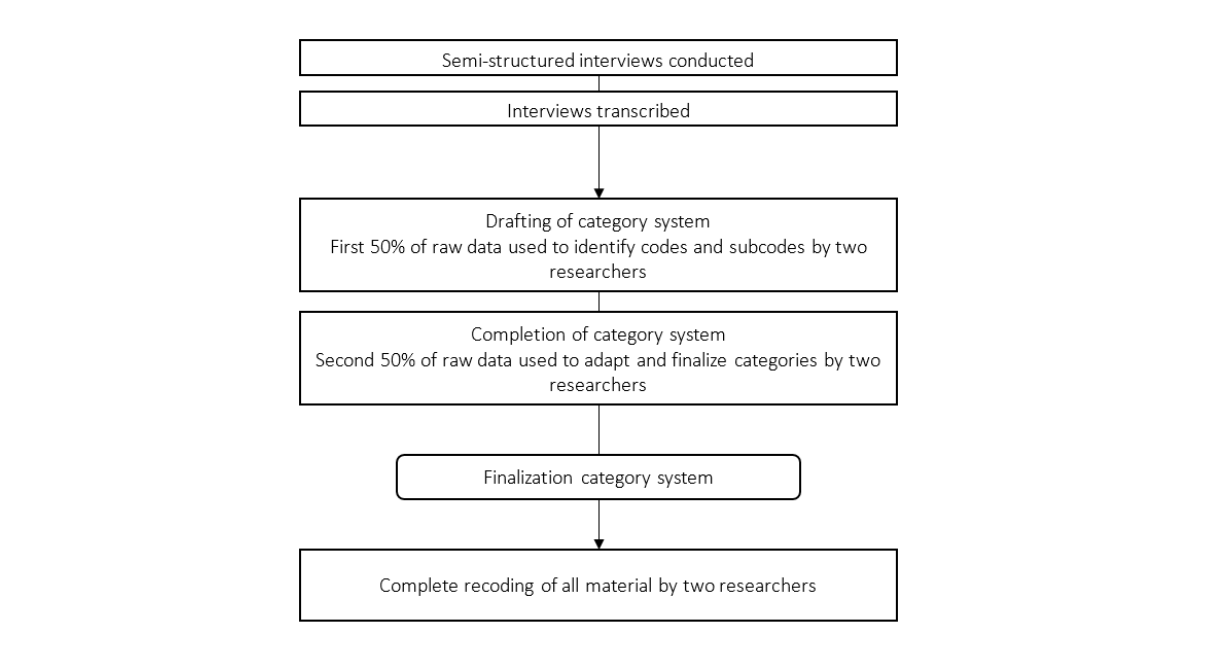
Figure 2. Study flow qualitative data